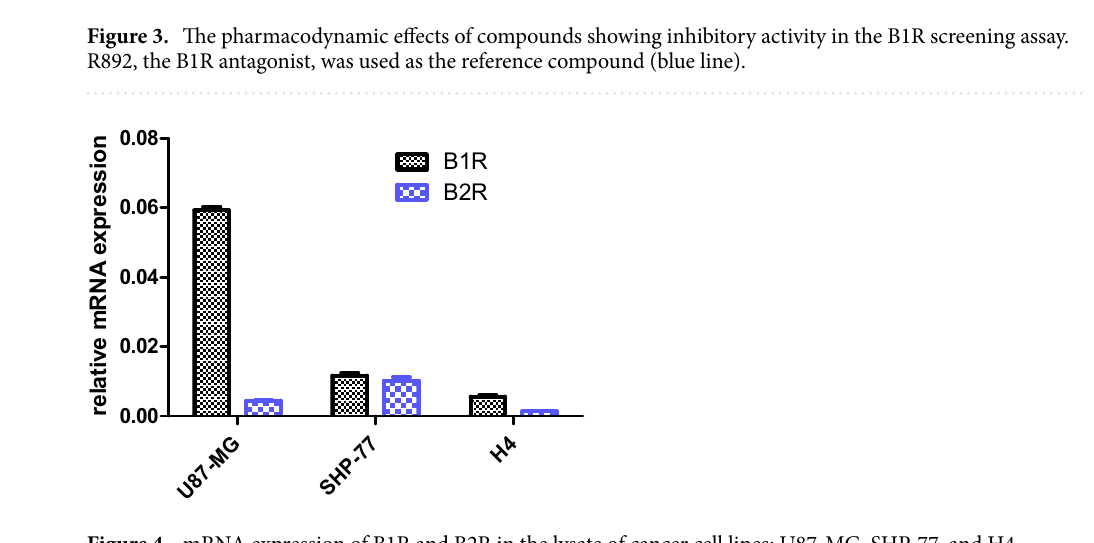
Figure 4. mRNA expression of B1R and B2R in the lysate of cancer cell lines: U87-MG, SHP-77, and